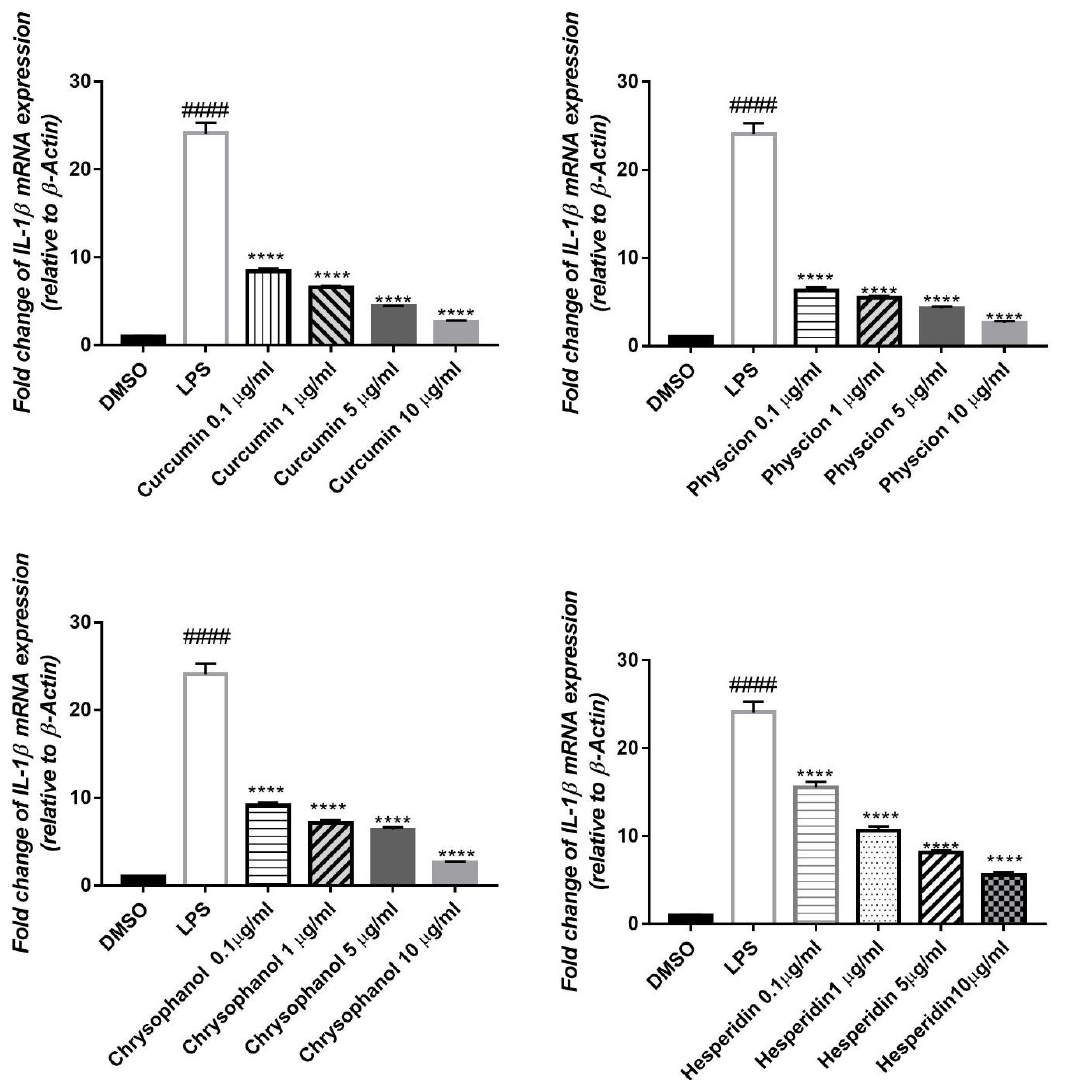
Figure 4. Effects of compounds (1–4) on the elevated level of IL-1β expression induced by 1 µg/mL LPS in HepG2, relative to β-Actin. qPCR was used for detection of mRNA expression. Data were given as ± S. E ( n = 3), #### p < 0.0001 compared with control. **** p < 0.0001 compared to LPS.